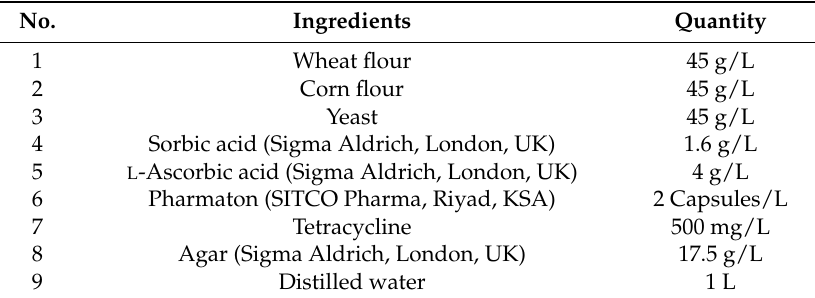
Table 5. Nutritional ingredients for rearing red palm weevils on artificial diet. No.